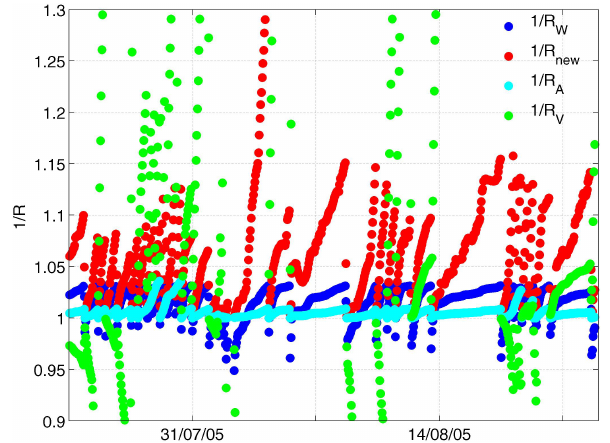
Fig. 2. 1/ R for the four filter-loading corrections as a function of time for about one month measured at the JFJ at λ